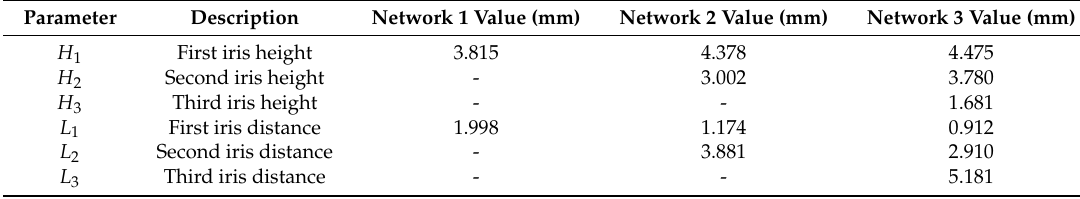
Table 5. Matching networks optimized geometrical parameters.